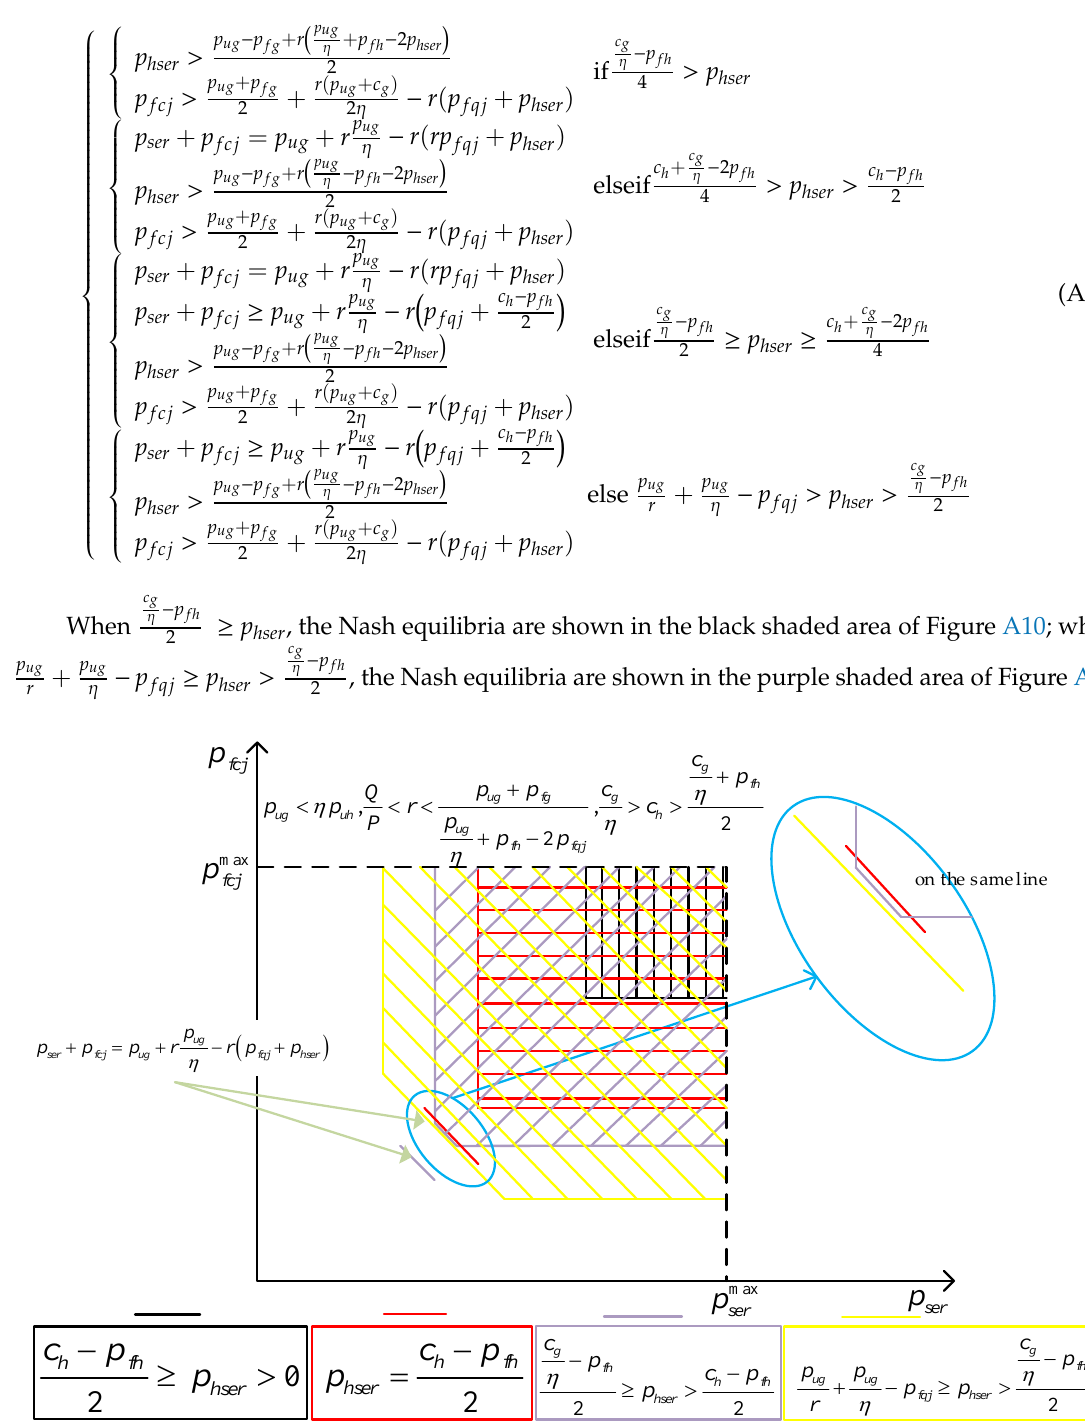
Figure A9. Scenario 9: two-dimensional sketch of the tripartite game Nash equilibria.